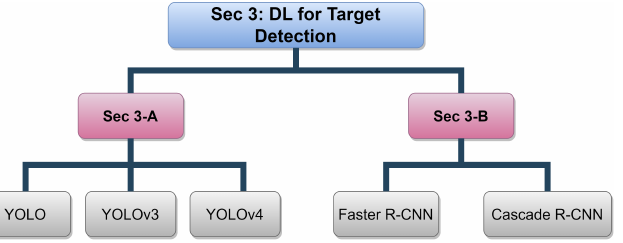
Figure 6. The main prototype of the DL family utilized for target